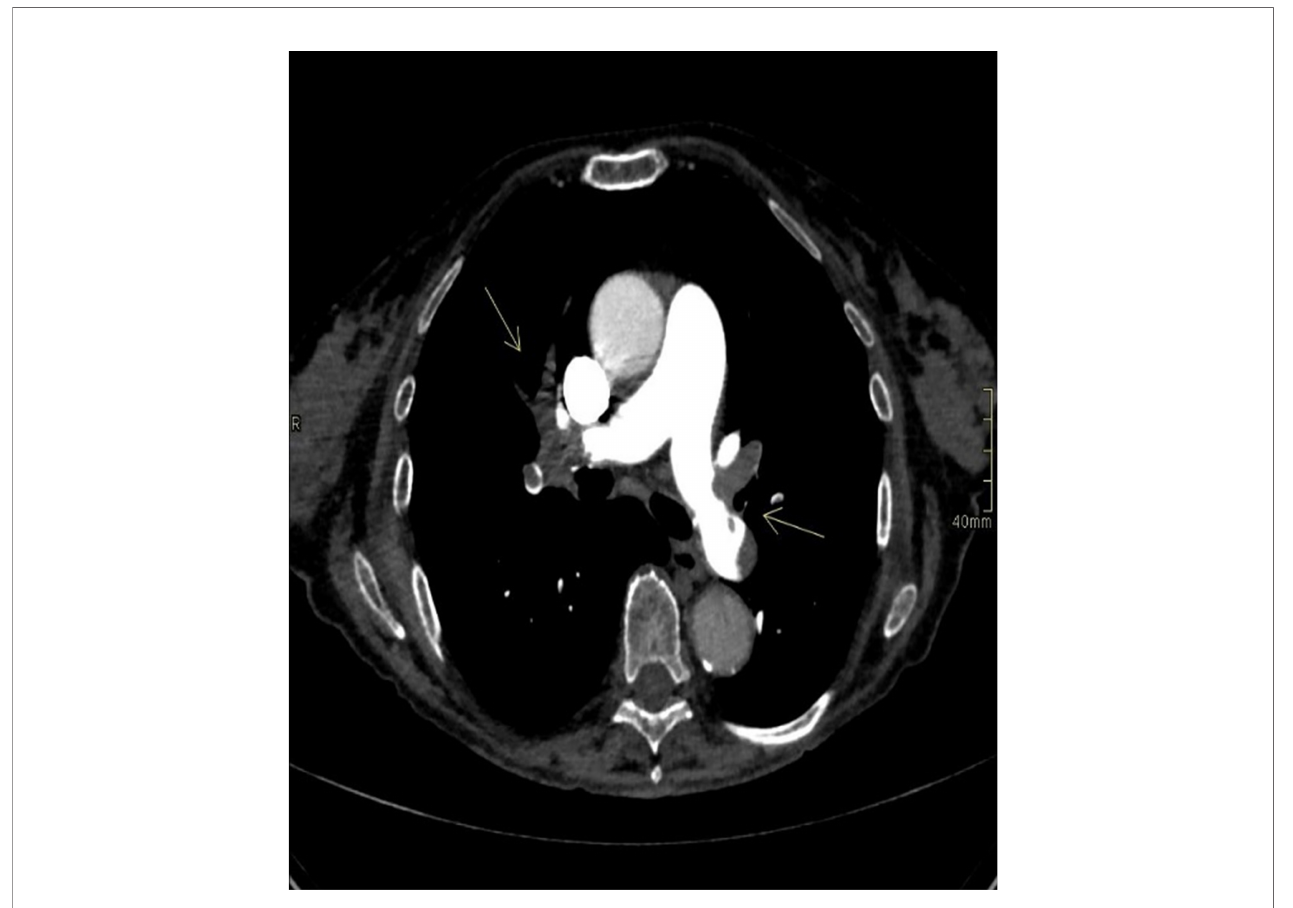
FIGURE 3 | Chest CT scan: the arrows show bilateral lobar and segmental pulmonary